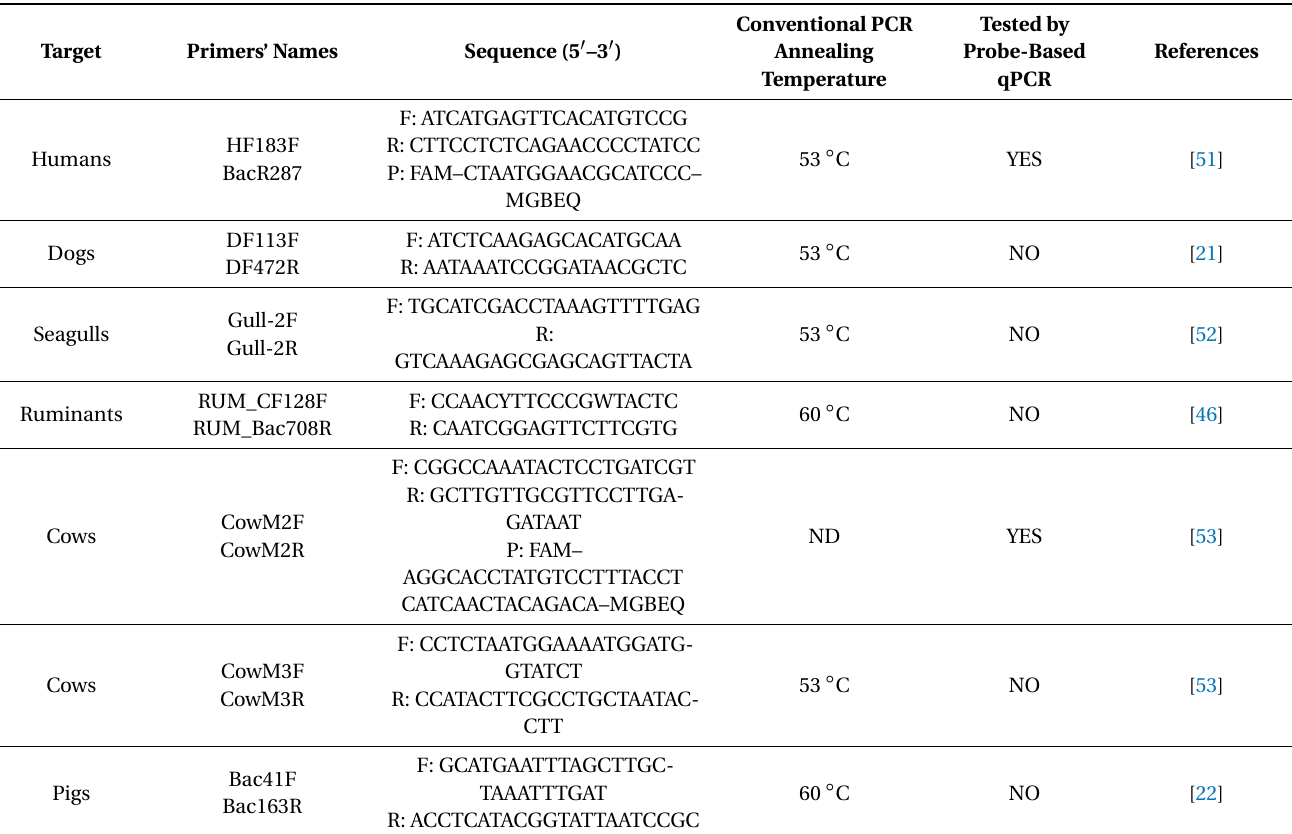
Table 1. List of microbial source tracking primers used and their respective sequence, annealing tempera- tures, and conditions tested, as well as the original reference that described